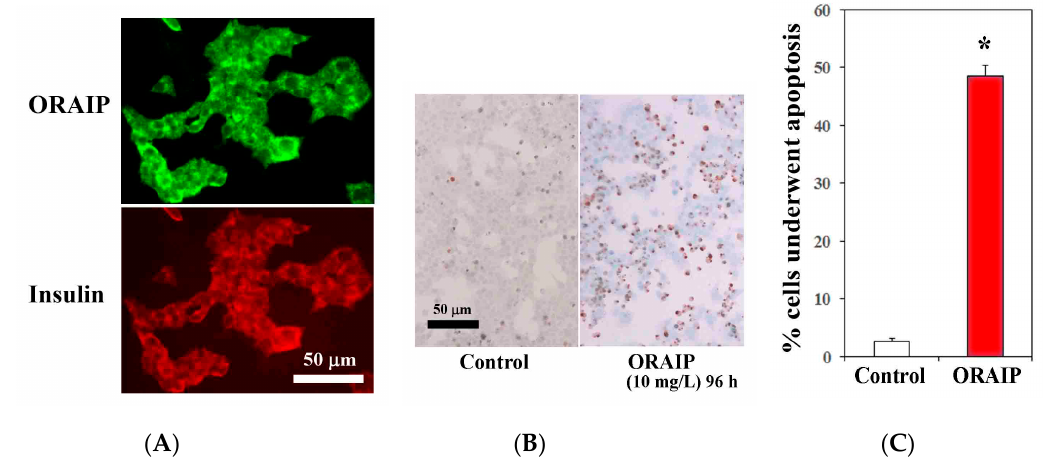
Figure 4. Expression of ORAIP in murine pancreatic β -cells (MIN6) and recombinant-ORAIP induces apoptosis in MIN6 cells in vitro . ( A ) Immunofluorescent localization of ORAIP proteins in cultured murine pancreatic β -cells (MIN6) under (25.0 mM) concentration of glucose. ( B ) Induction of apoptosis in MIN6 cells by treatment with recombinant-ORAIP (10 mg/L) for 96 h as determined by TUNEL staining. Bar, 50 μ m. ( C ) The percentage of apoptotic MIN6 cells treated by recombinant-ORAIP. The data are expressed as the mean ± SE. ( n = 4 for each). * p = 0.000059 vs. Control (Welch’s t -test).